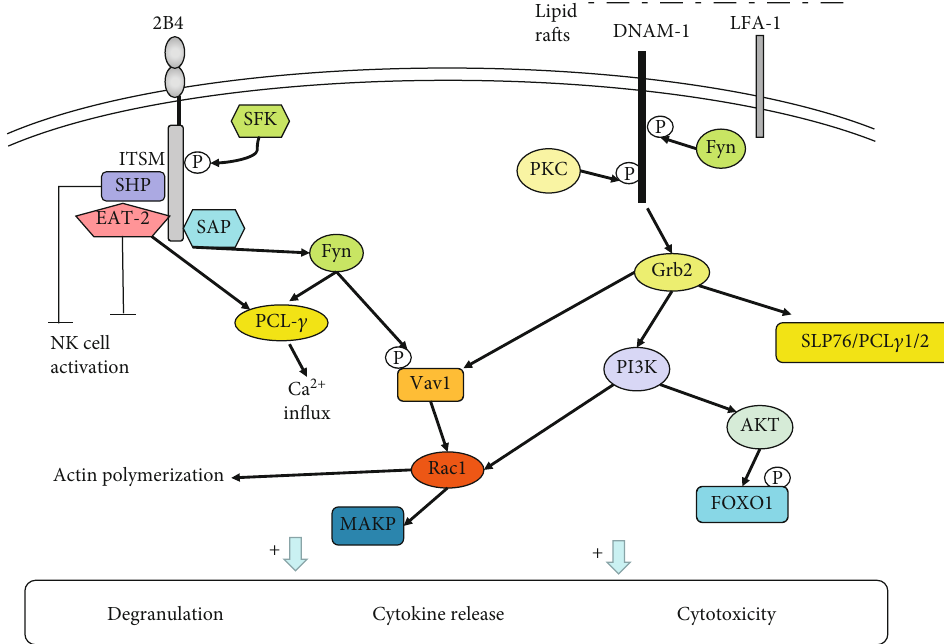
Figure 4: Signaling pathways of 2B4 and DNAM-1. Binding of 2B4 to CD48 promotes ITSM phosphorylation and recruits the adaptor SAP. SAP combines with ITSM to recruit Fyn, and Fyn phosphorylates the downstream proteins PLC γ and Vav1 to activate NK cells. 2B4 can also recruit the phosphatases SHP-1/SHP-2 in the absence of SAP, transmitting inhibitory signals. The 2B4-EAT2 complex may have opposite functions in NK cells. DNAM-1 binds to its ligand, and it is phosphorylated by PKC and Fyn, which promotes the interaction between DNAM-1 and LFA-1. Eventually, DNAM-1 is recruited to the lipid raft and binds to the adaptor Grb2. Binding of DNAM-1 to Grb2 enables PI3K, Vav1, SLP76, and PLC γ 1/2 to be recruited and then activates the AKT and ERK signaling pathways, thus triggering degranulation and calcium mobilization. In addition, activated AKT catalyzes FOXO1 phosphorylation. Phosphorylated FOXO1 is transferred from the nucleus to the intracellular space, where it is inactivated and degraded, regulating NK cell cytotoxicity and exerting antitumor e ff